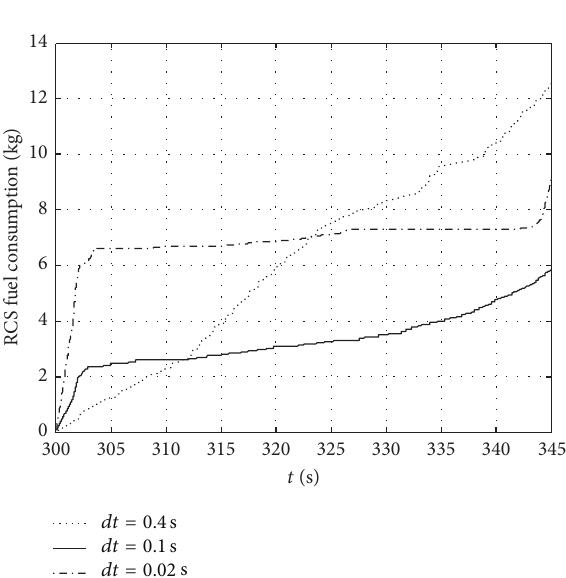
Figure 38: Simulation result of RCS